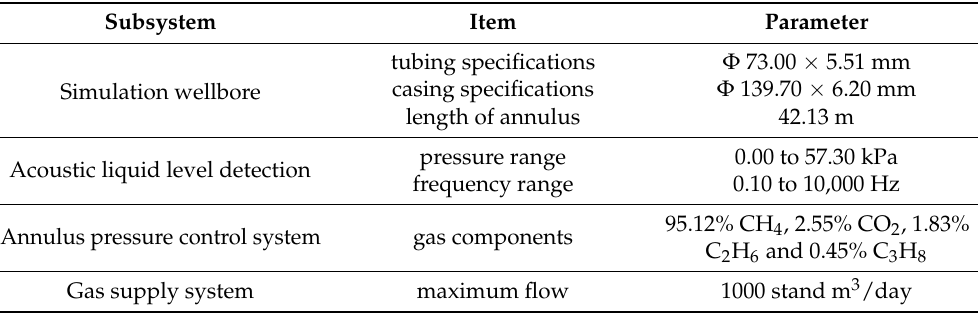
Table 1. The main parameters of the experimental devices.